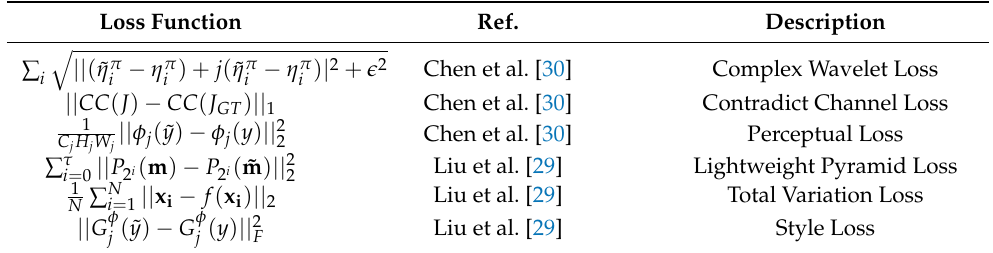
Table A1. Listing of loss functions used by desnowing